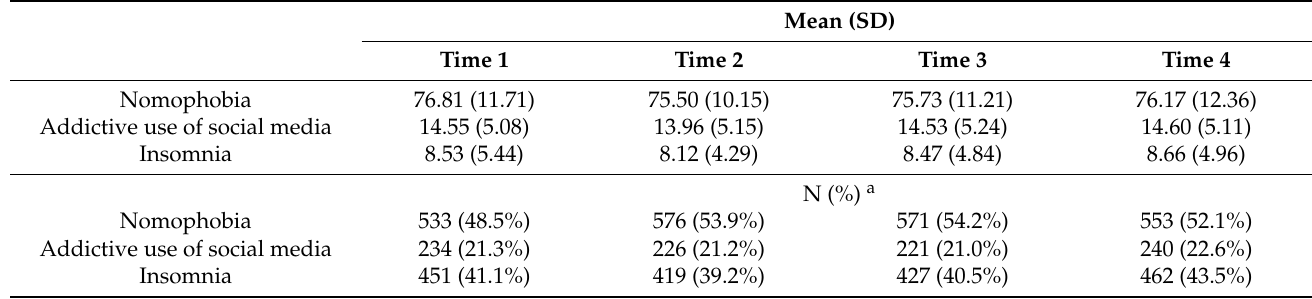
Table 2. Nomophobia, social media addiction, and insomnia across time.